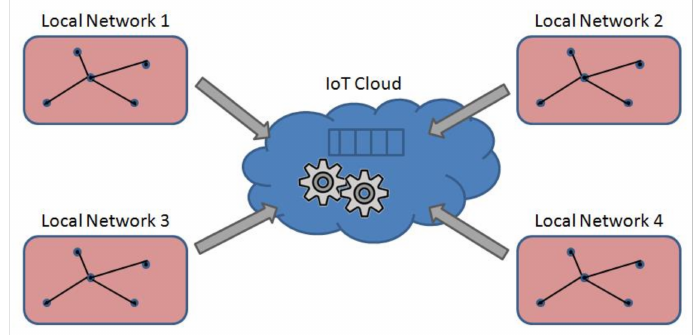
Figure 1. System model.